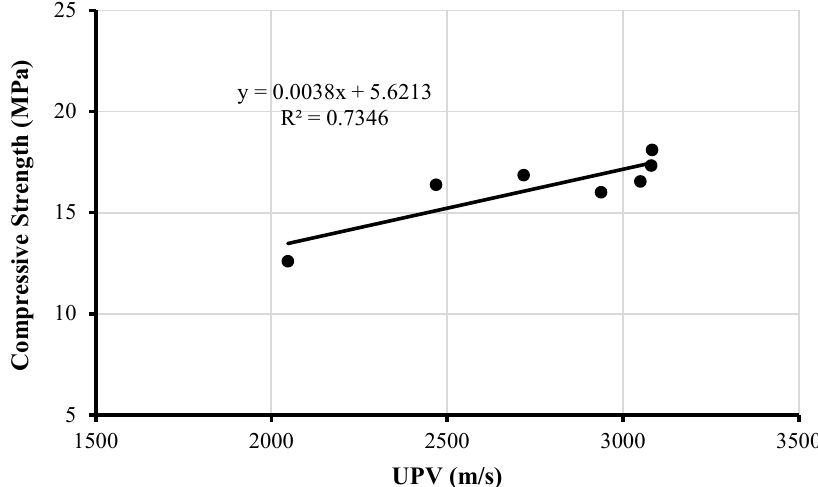
Figure 9. UPV vs. compressive strength of 25-year-old bricks.